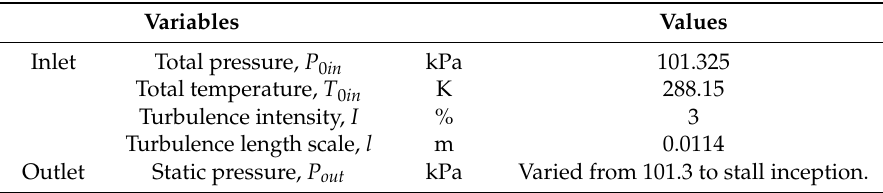
Table 1. Flow conditions used for the numerical